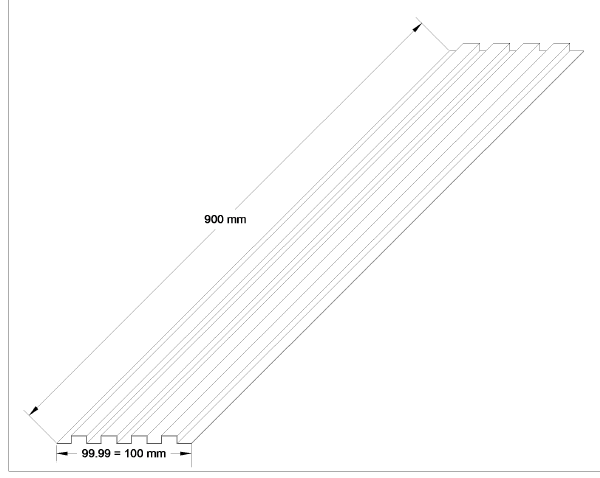
Figure 1: Cross section of rectangular corrugated profile